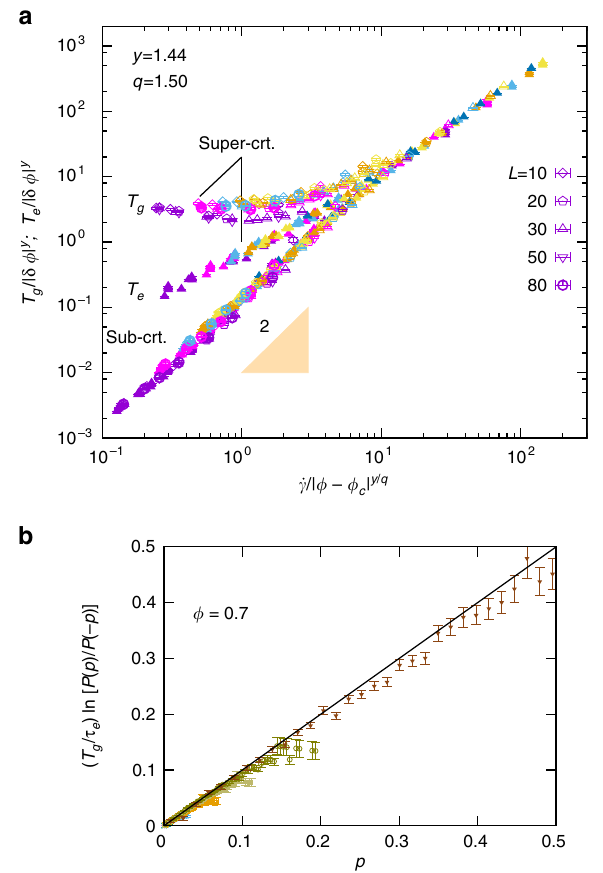
Fig. 4 Scaling of effective and kinetic temperatures. a When rescaled with the critical exponents q = 1.5(1) and y = 1.44(15) the effective and granular temperatures collapse onto a scaling function. However, to achieve a data collapse we had to adopt slightly different critical densities, ϕ c = 0.83 and ϕ = ϕ = 0.84 for T fl uid state and in the critical c J e and T g , respectively. In the state the temperatures match. For the fl uid state they exhibit Bagnoldian scaling with exponent 2. In the critical state they still share same non-trivial scaling for _ γ = δϕ y = q \ 10. In the jammed state the temperatures segregate into two different branches; T e approaches a constant and T g follows a power-law behavior with exponent 1.5(1). Different system sizes are given by different symbols in which fi lled and hollow symbols refer to T g and T e , respectively. The color code corresponds to different shear rates _ γ ¼ 0 : 02 ( purple ), 0.04 ( magenta ), 0.06 ( blue ), 0.08 ( golden ), and 0.1 ( yellow ). b The collapse of all data presented in Fig. 4a when the vertical axis is multiplied by a factor of T g / τ with τ = 0.28. In these data, we cover a large range of packing fractions around jamming, 0.7 < ϕ < 0.9. Error bars correspond